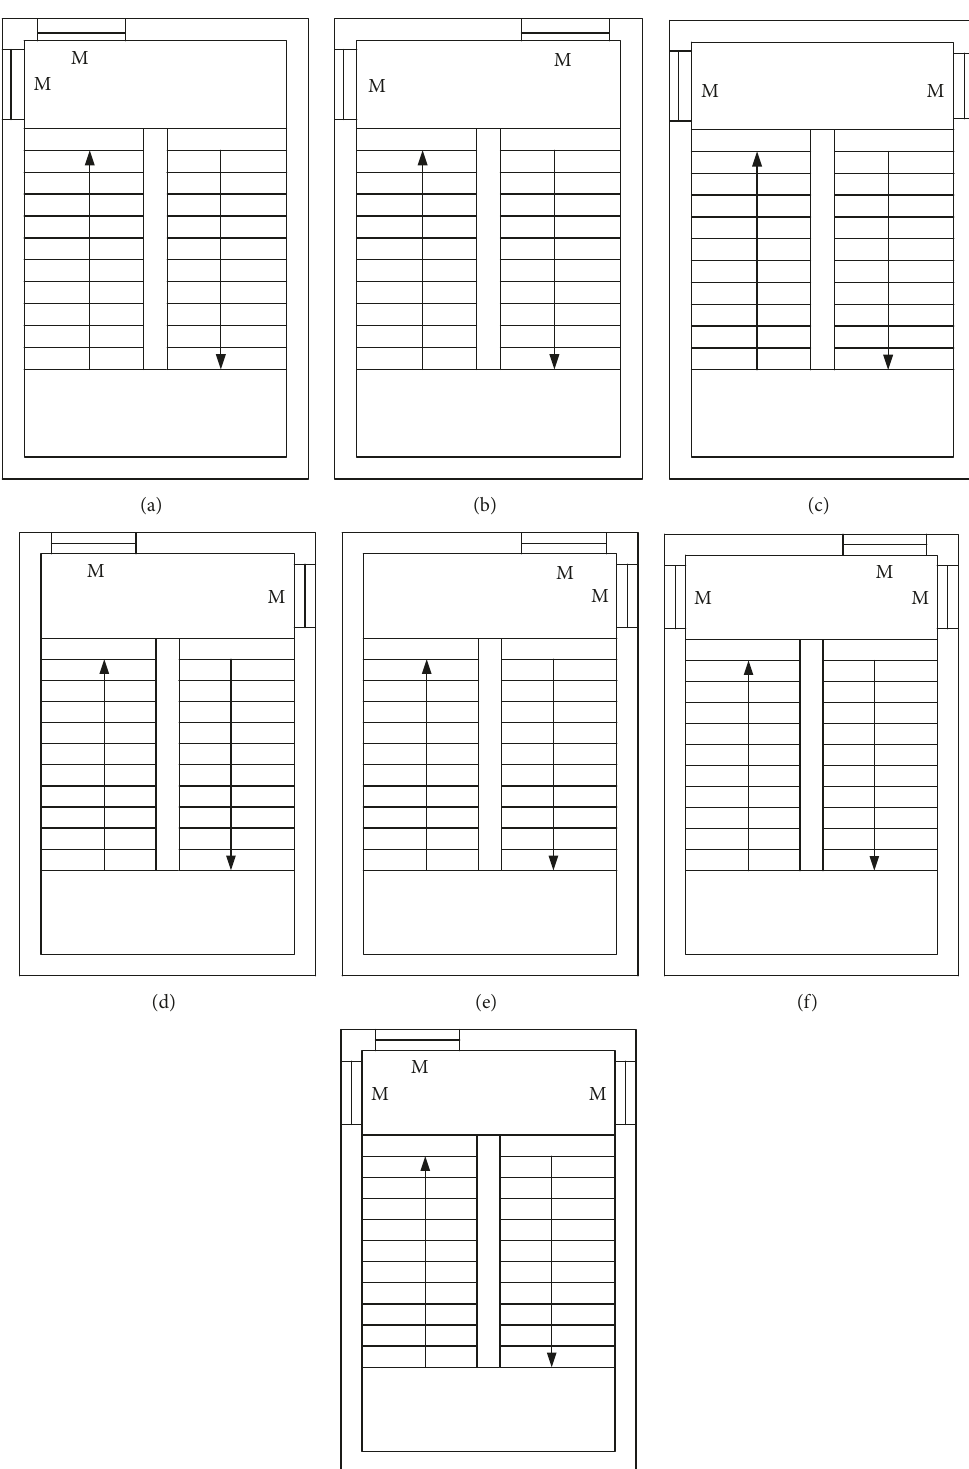
Figure 3: The merging form of stairs when there are more than one floor entrance and the different combination of floor